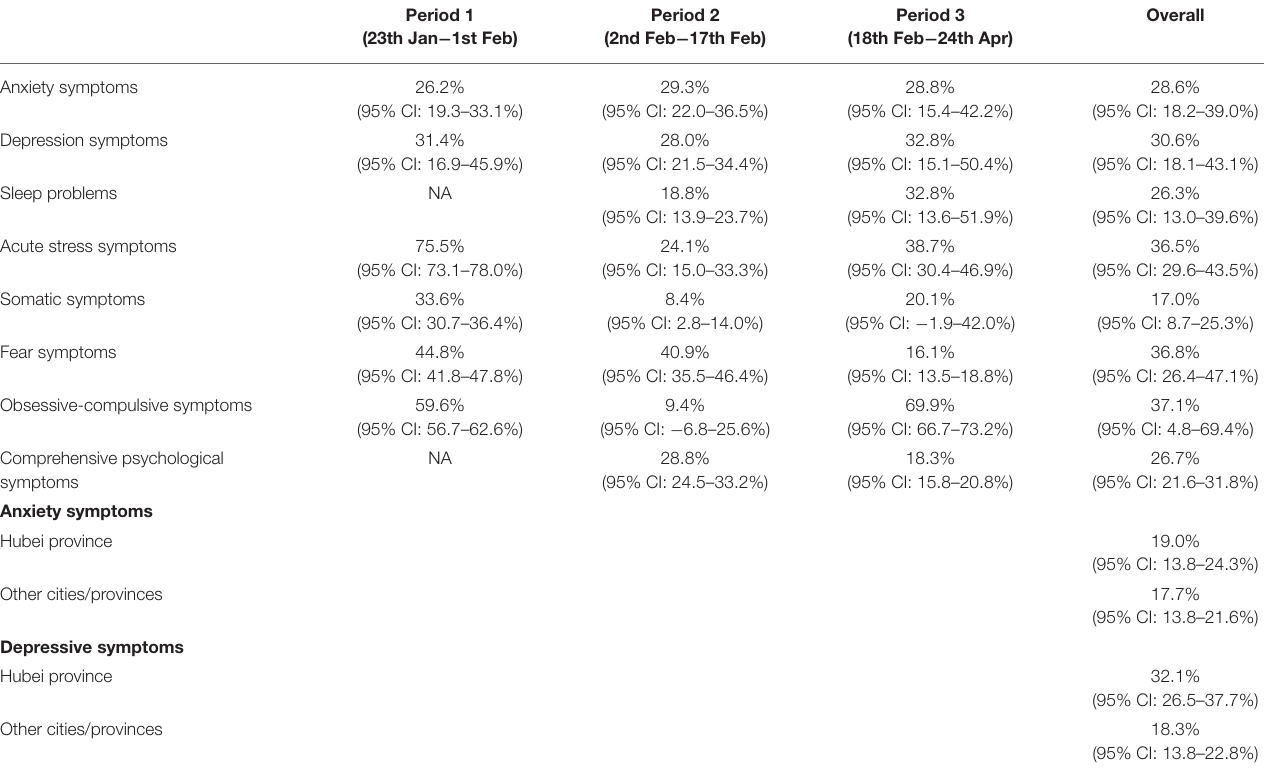
TABLE 2 | Sensitivity analysis: the prevalence of different psychological statuses after removing small-sample